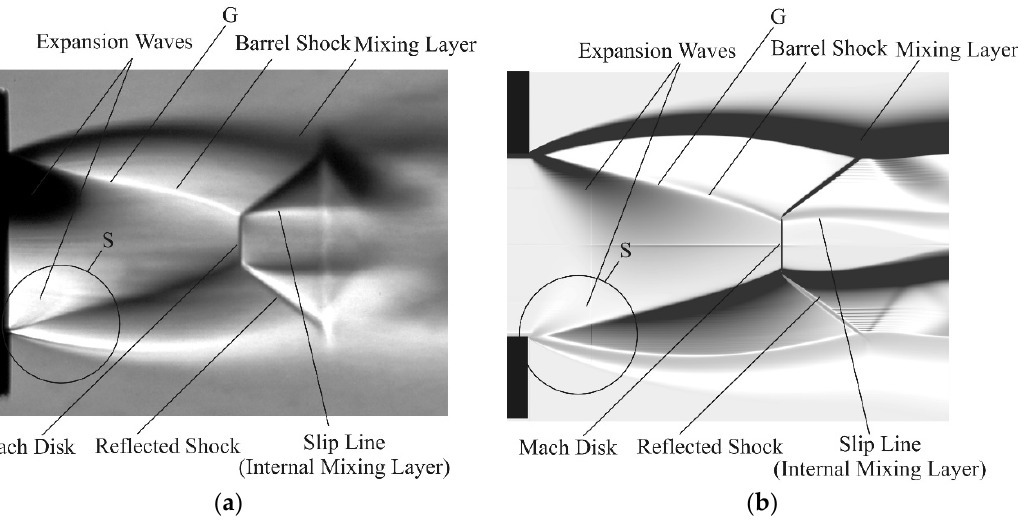
Figure 6. The first barrel of the jet ejected from the nozzle with M a = 1 and n = 2.64: ( а )—schlieren photograph taken at 2-ms exposure, ( b ) visualization of calculated data. Here G is the gradient flow feature, S is the region of its S-bending shape.